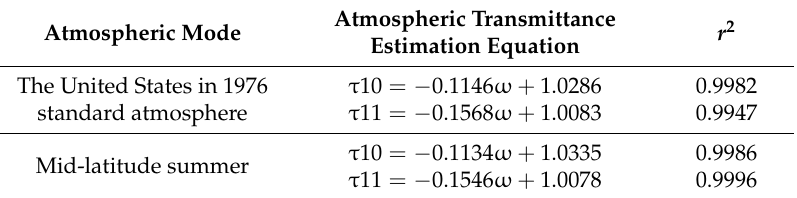
Table 3. Relationships between atmospheric transmittance ( τ ) and water vapor ( ω ) content when the water vapor content is from 0.5 to 3 g/cm 2